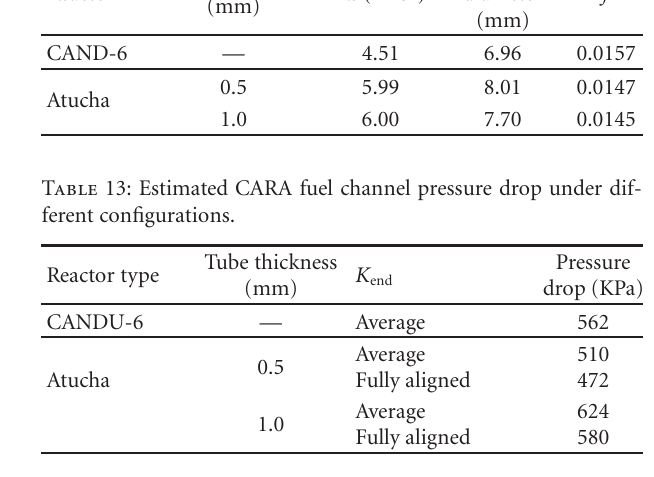
Figure 14: Distributed fiction loss coe ffi cient.